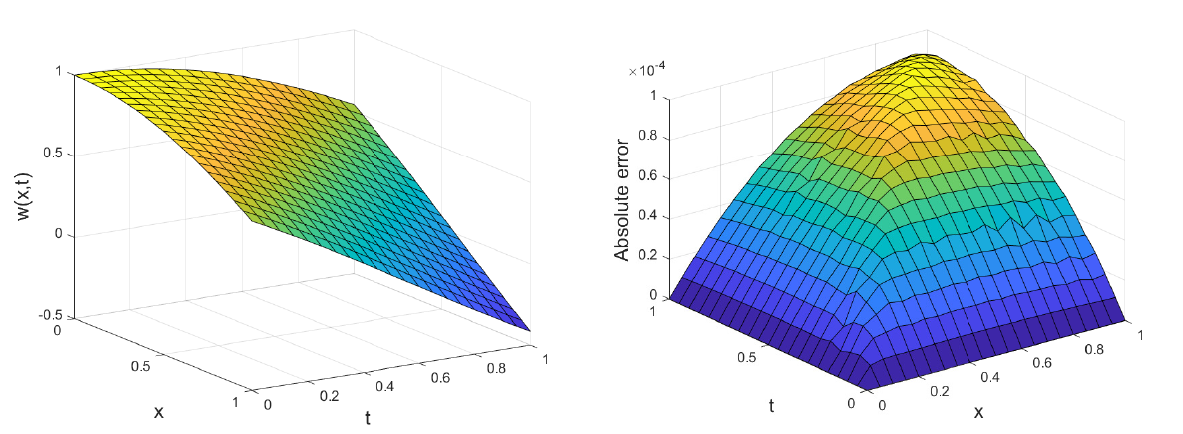
Figure 2. Plot of the approximate solution ( left ) and L ∞ errors ( right ) taking r = 5 and J = 2 for Example 1.